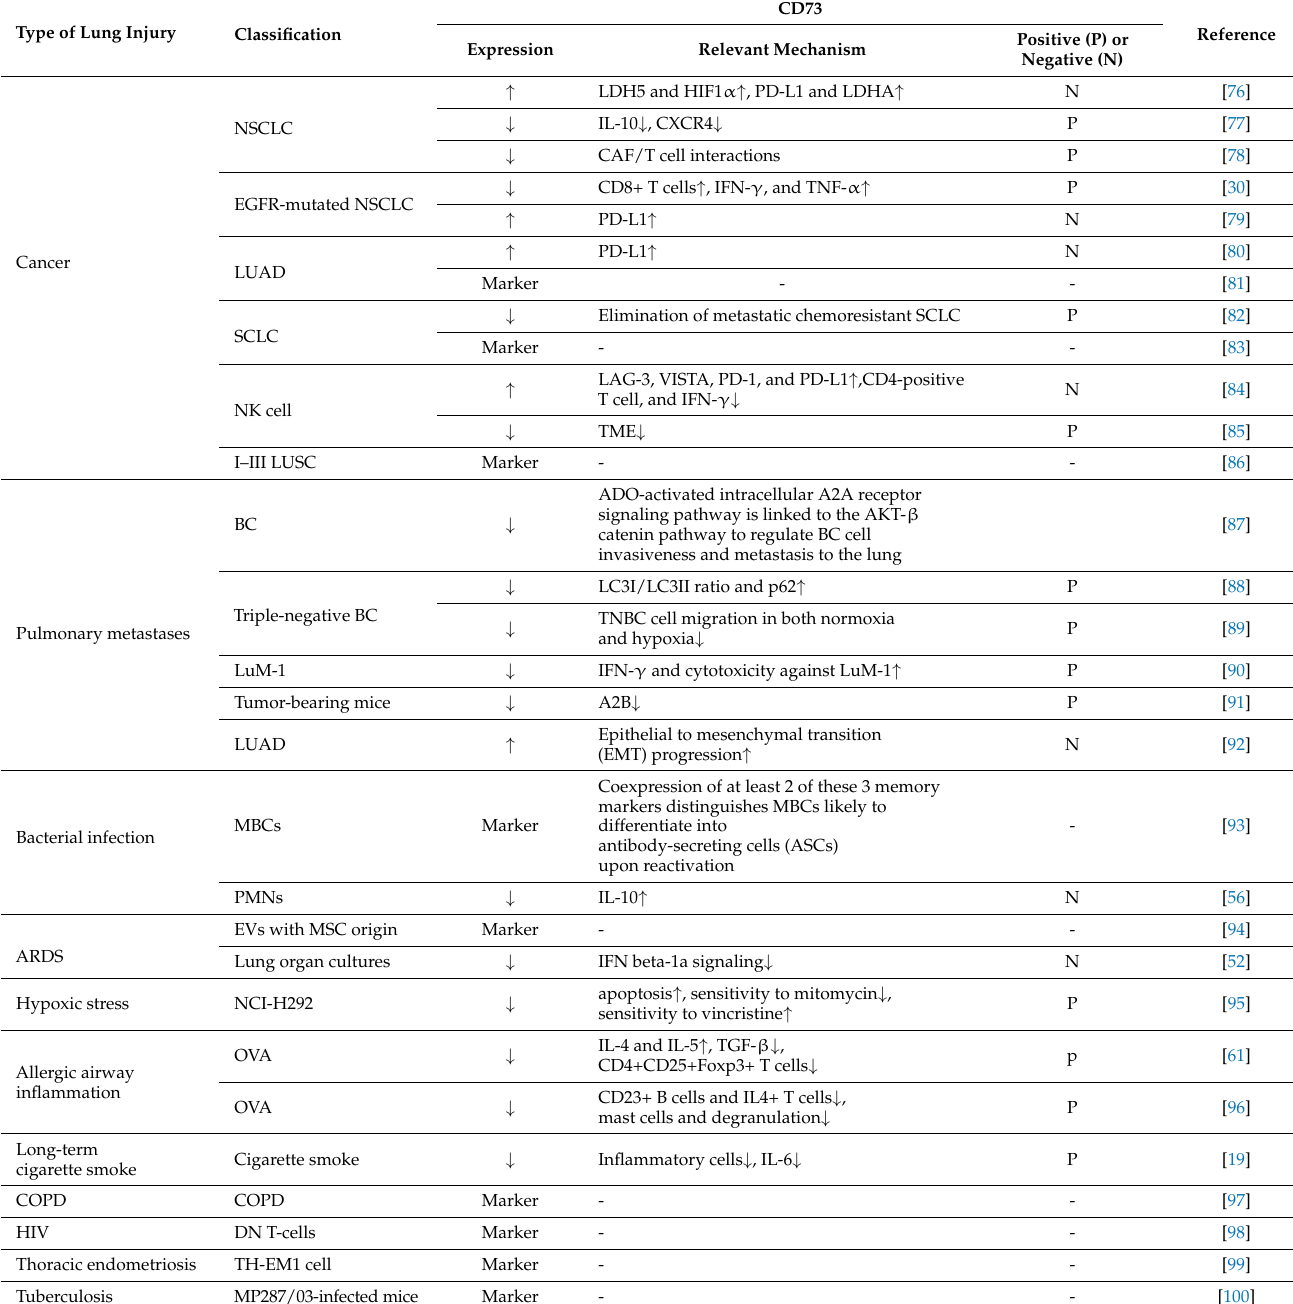
Table 1. Role of CD73 in different types of lung